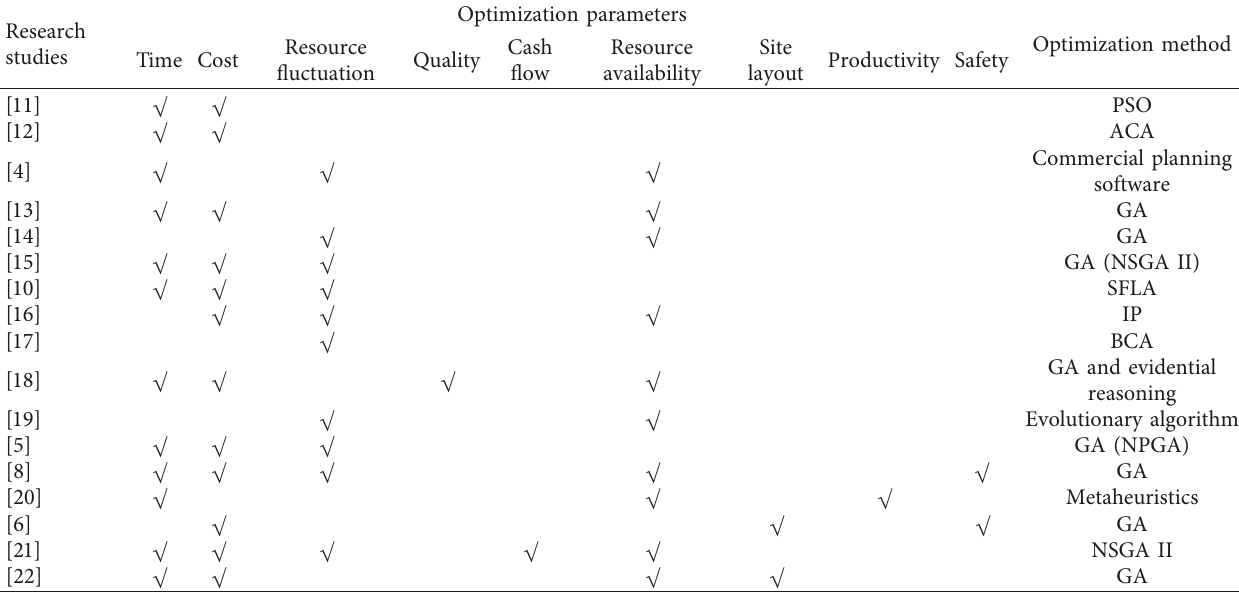
Table 1: Optimization parameters and methods for the project scheduling